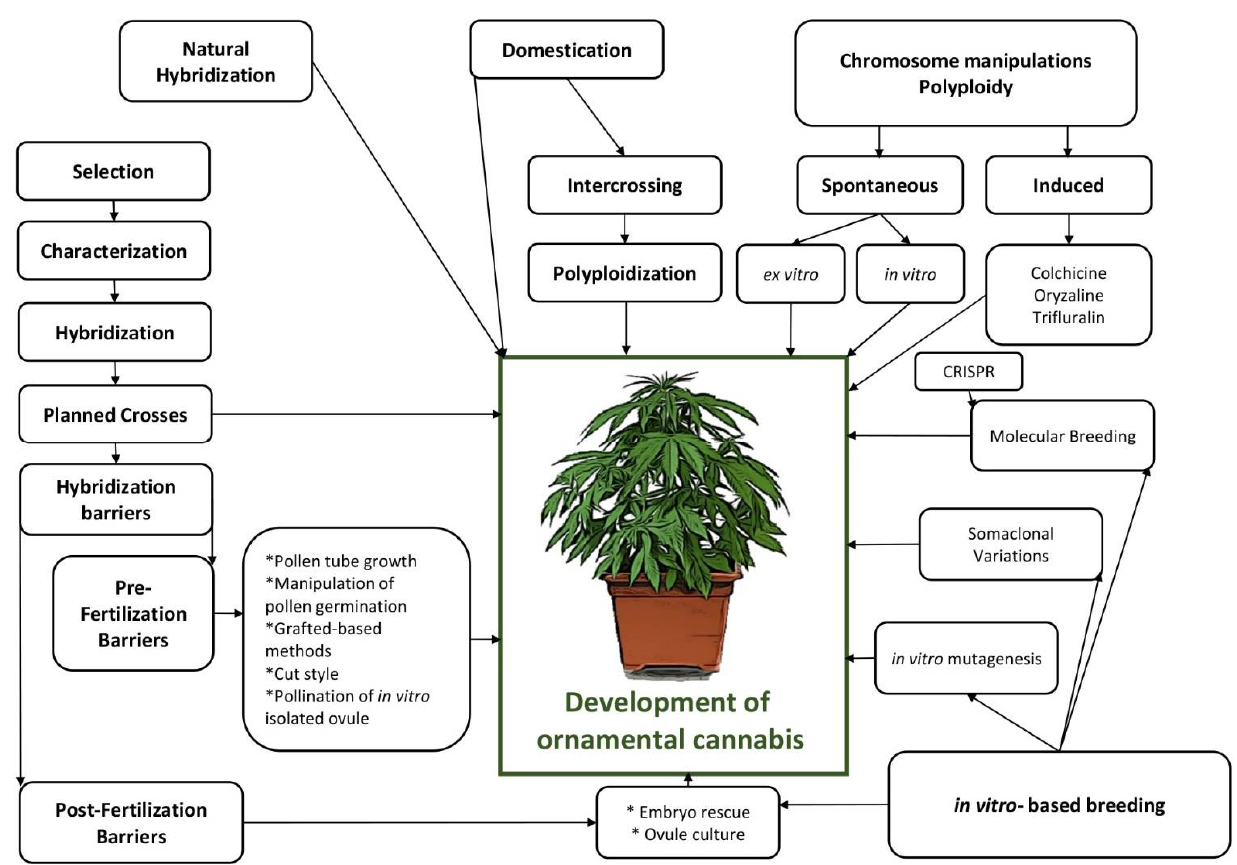
Figure 4. A schematic view of different breeding-based approaches for producing ornamental can- nabis.